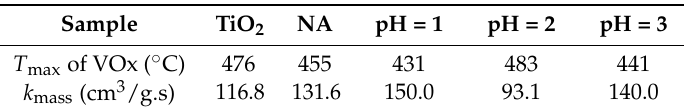
Table 3. Position of VO x peak maxima ( T max ) obtained from H 2 ‐ TPR analysis and the mass rate constant ( k mass ) at 300 °C of NO ‐ NH 3 reaction.